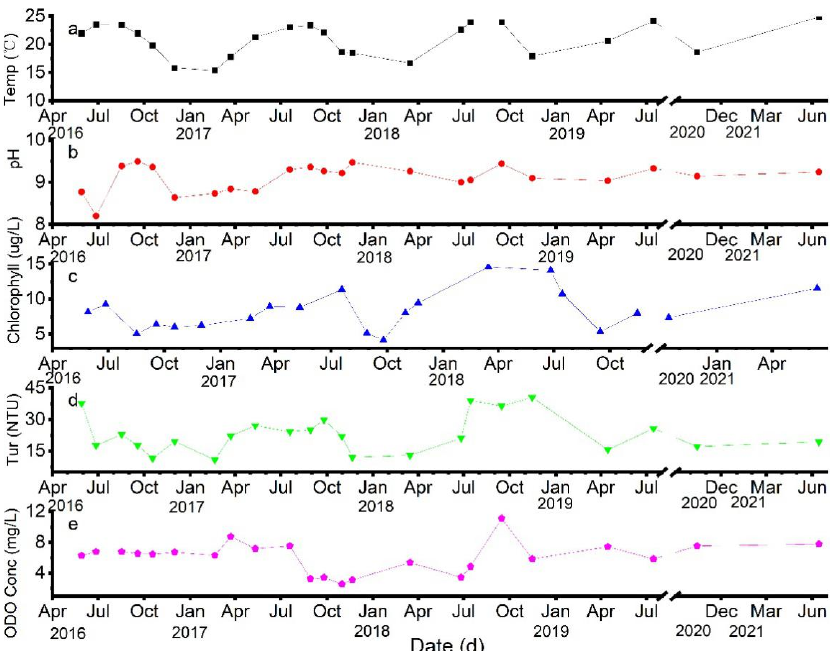
Figure 8. Water quality trend lines of Lake Xingyun from 2016 to 2021. ( a ) TW. ( b ) pH. ( c ) Chl-a. ( d ) Turbidity. ( e ) DO.